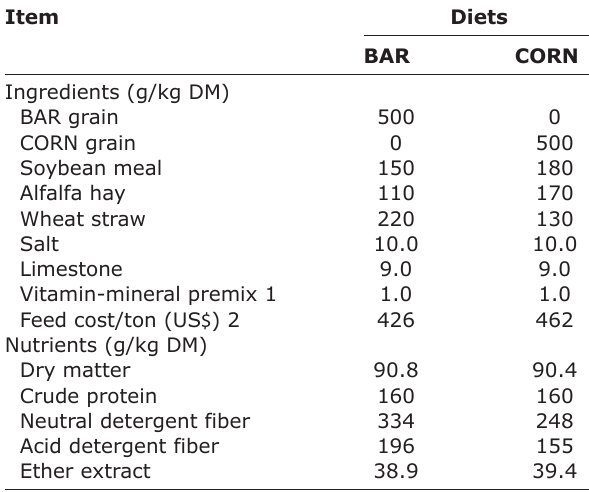
Table-1: Ingredients and chemical composition of diets containing either BAR or CORN grains fed to Awassi